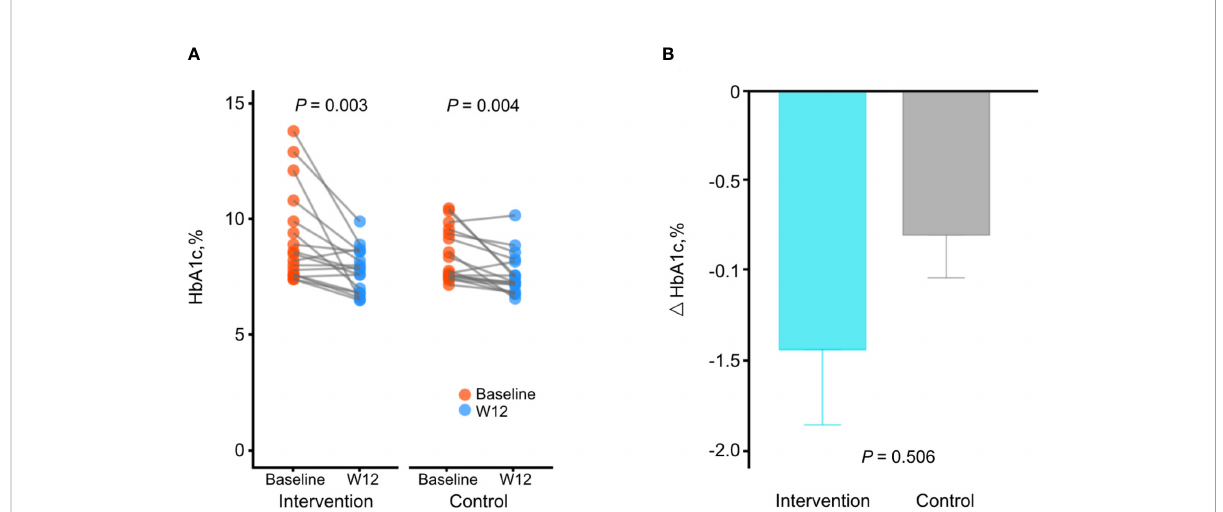
FIGURE 1 Changes in HbA1c levels during the study. (A) Comparison of HbA1c levels between baseline and week 12 in each group. P by paired t -test. (B) Comparison of changes of HbA1c levels between the intervention group and the control group. P adjusted for baseline values using analysis of covariance. Data are presented as the mean ±